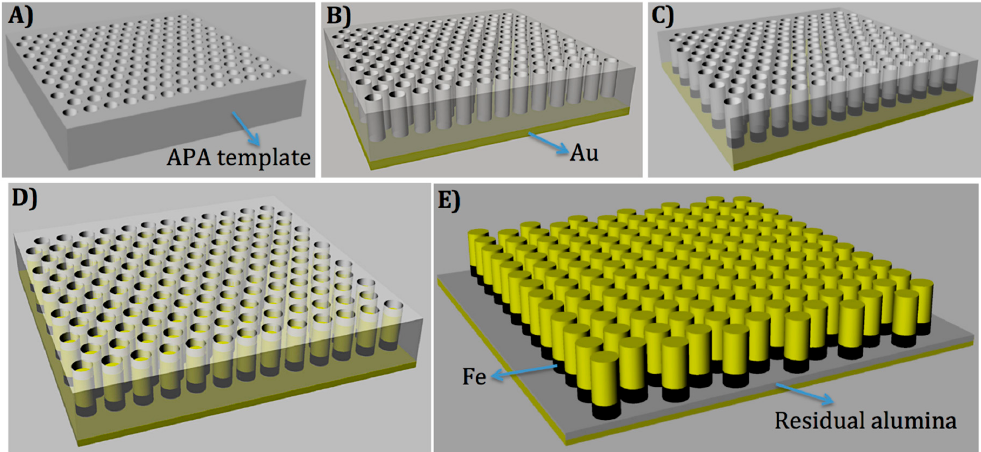
Figure 1. Schematic diagram of forest-type nanowire fabrication. ( A ) Anodic porous alumina (APA) template; ( B ) after gold evaporation on the backside of pores and etching out of aluminum layer; ( C ) after the electrodeposition of Fe in the APA pores; ( D ) after the electrodeposition of Au pores; and ( E ) after partial etching of alumina (residual layer of alumina), forming the final SERS device with Au nanowires (on top).